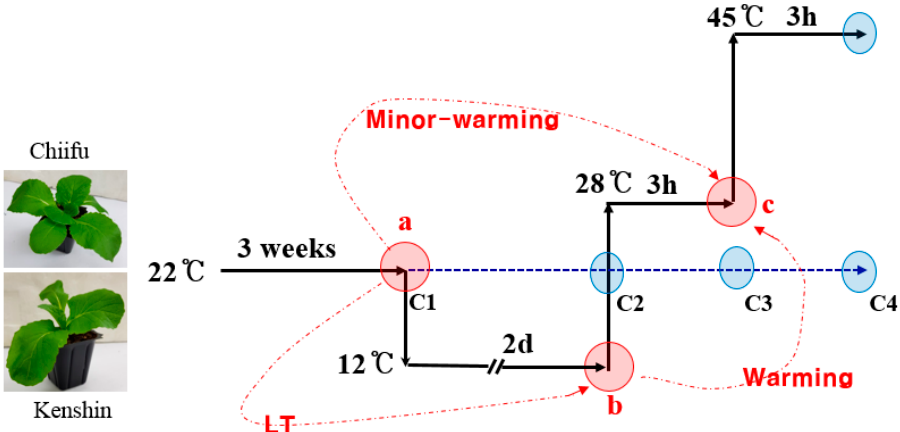
Figure 1. Temperature treatment and sampling schedule. Collection times are indicated by circles. Red circles ( a – c ) represent sampling times for the microarray experiments as well as qRT-PCR analysis. Blue circles indicate that the collected samples were only used for qRT-PCR. Shoots from five individual plants were sampled and frozen in liquid nitrogen. Treatments were as follows: ( a ) (22 °C) to ( b ) (12 °C); low-temperature (LT) conditions; ( a ) (22 °C) to ( c ) (28 °C), minor-warming conditions; and ( b ) (12 °C) to ( c ) (28 °C), warming conditions.